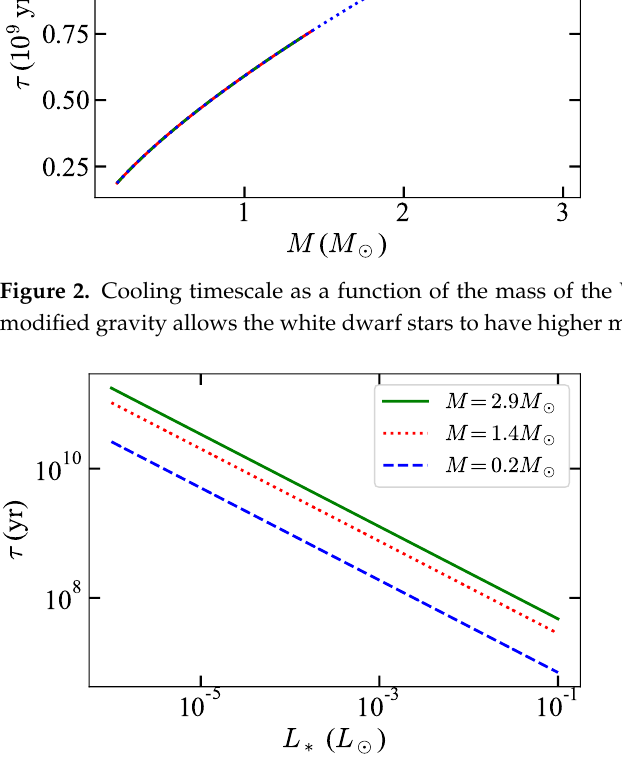
Figure 3. Cooling timescale as a function of the luminosity for WDs with different masses. Note that 2.9 M (cid:12) WD is possible only when α < 0. It is worth mentioning that the α value is not required explicitly to obtain this plot, because from Figure 2, it is evident that for a specific luminosity, cooling timescale depends only on the mass, and not the radius. Moreover, the 0.2 M (cid:12) WD can be obtained regardless of α being positive, negative or zero, and hence it is not necessary to precisely specify a value of α in order to determine its cooling